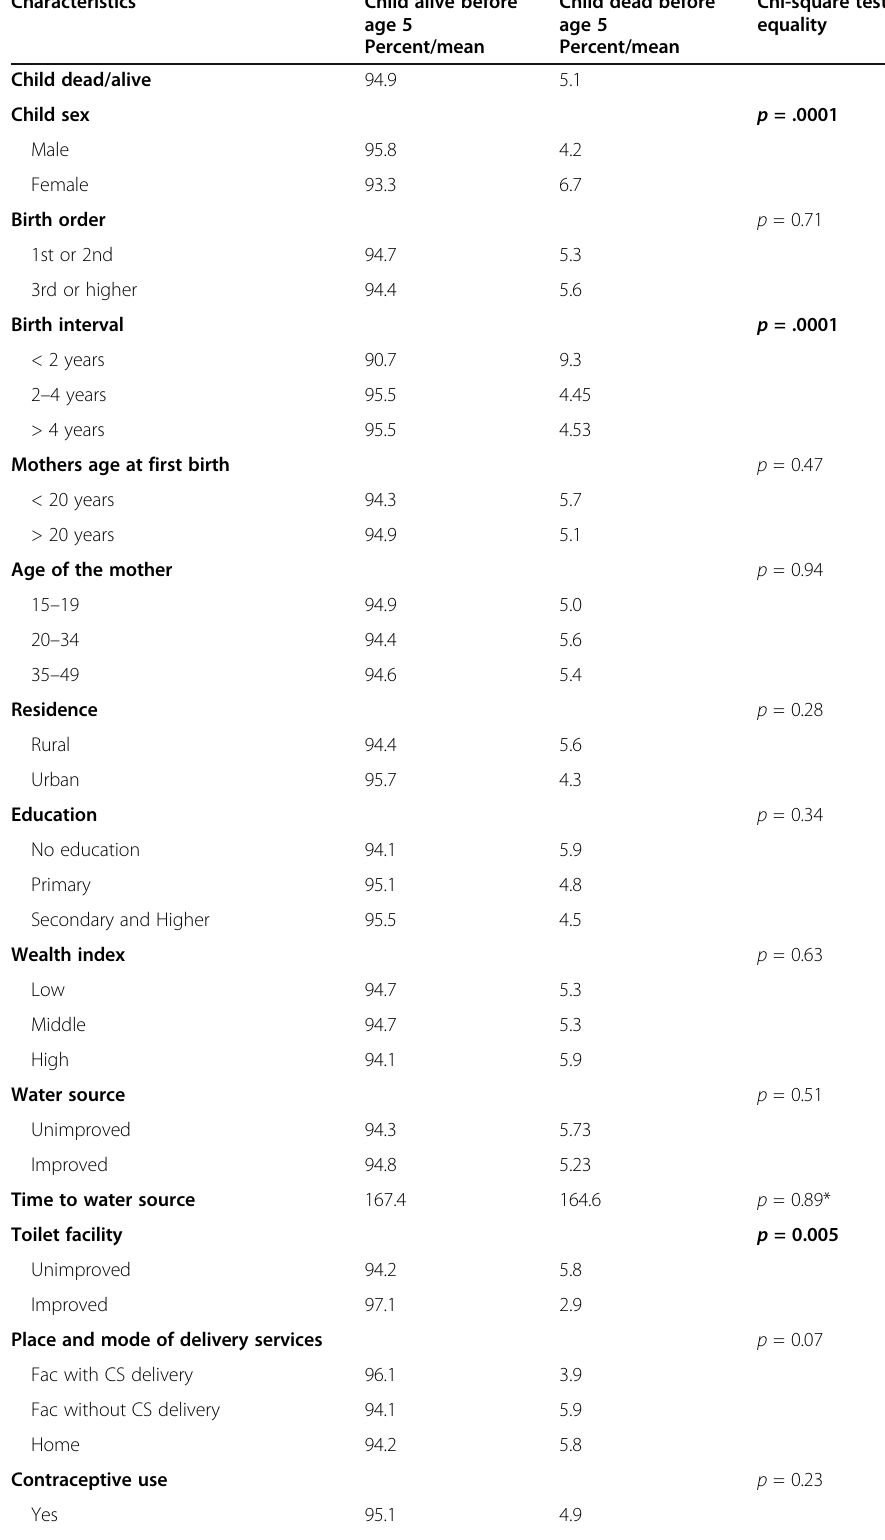
Table 1 Descriptive statistics of child mortality outcome by study characteristics, EDHS 2016 ( N =